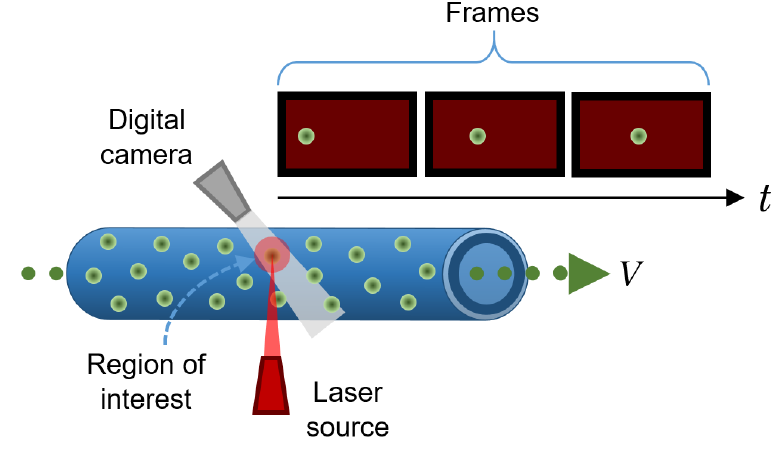
Figure 8. Schematic of a typical PIV setup.